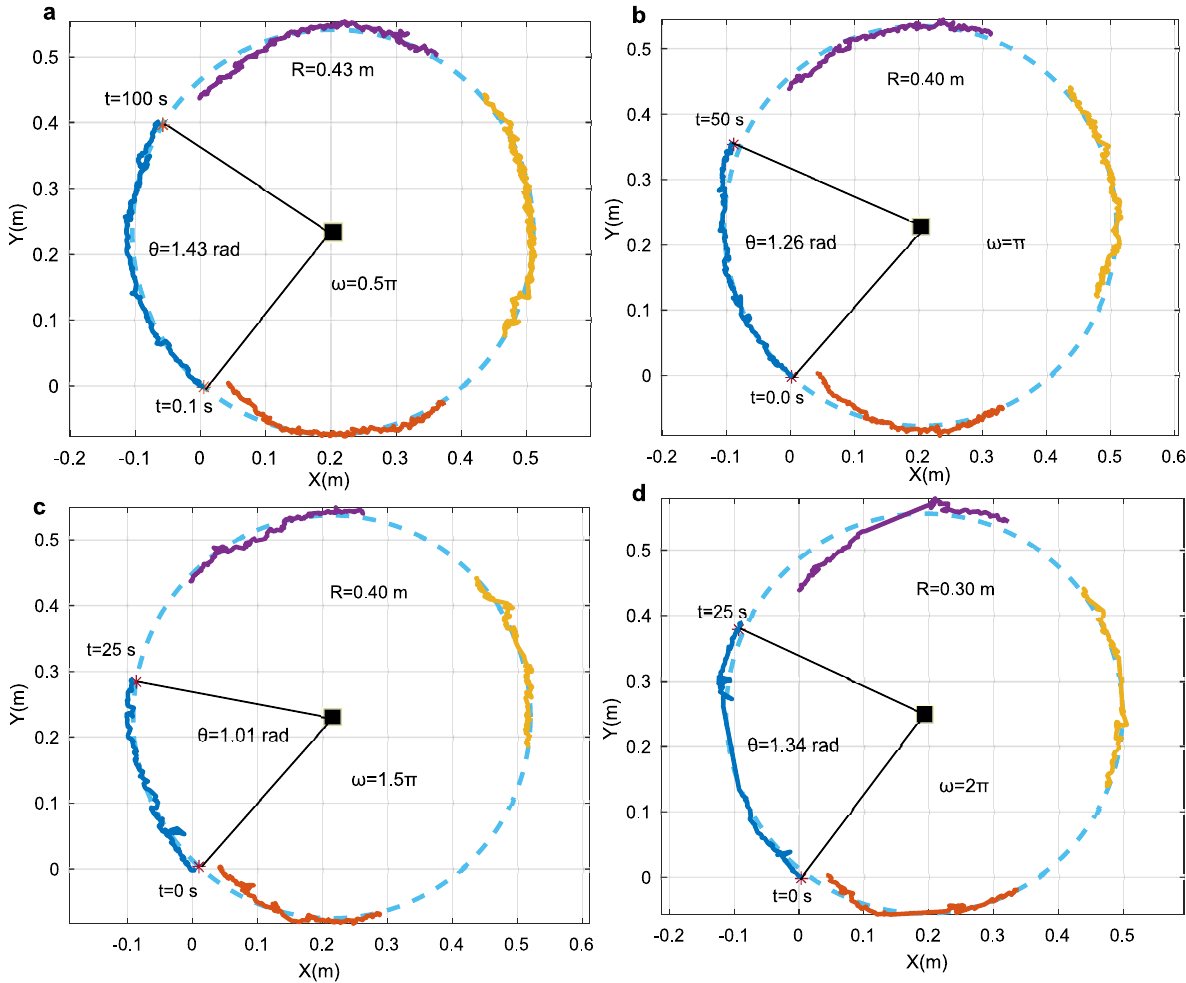
Fig. 15 Simulated trajectories of CMs M 11 , M 13 , M 33 , and M 31 , for spinning locomotion of WORMESH-II for IMF (wave parameters are A = 0.05 π and β = 4 π/ 3 ). a ω = π/ 2 . b ω = π . c ω = 3 π/ 2 . d ω = 2